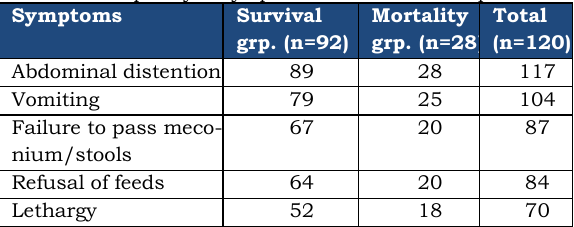
Table 1: Frequency of symptoms on arrival in our patients Symptoms Survival Mortality grp. (n=92)